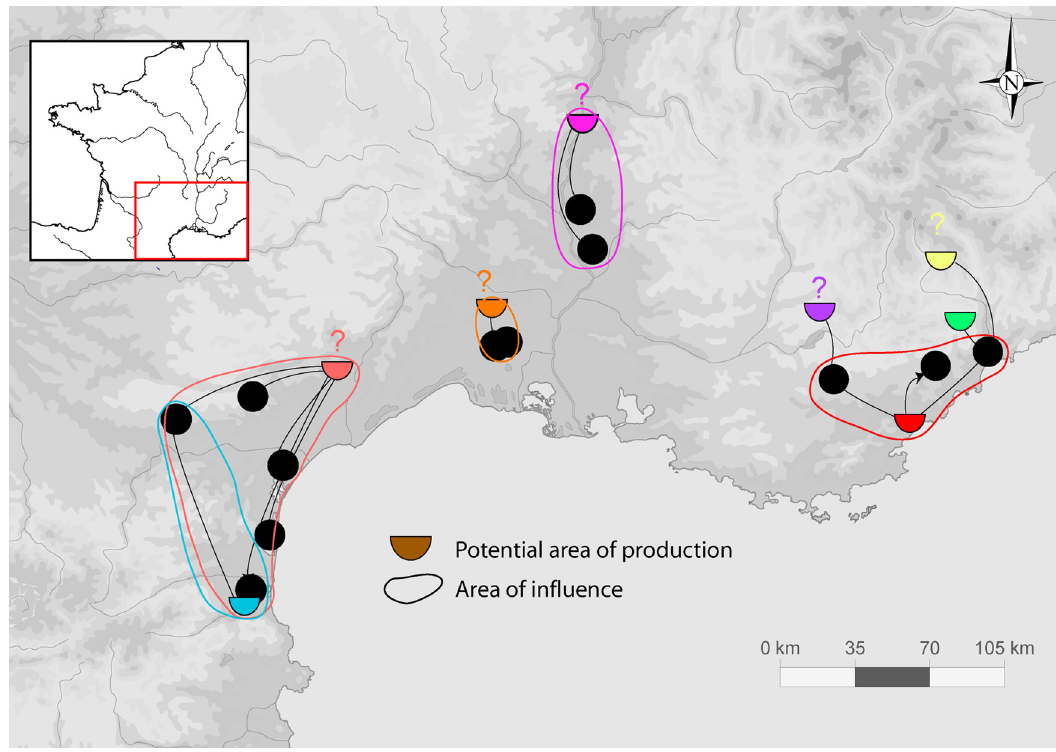
Figure 5: Map of the in fl uence areas and the territories based on the ceramic raw material analysis of the fi rst farmers communities in Southern France ( after Binder, Clop Garcia, Convertini, Manen, & Sénépart, 2010 )